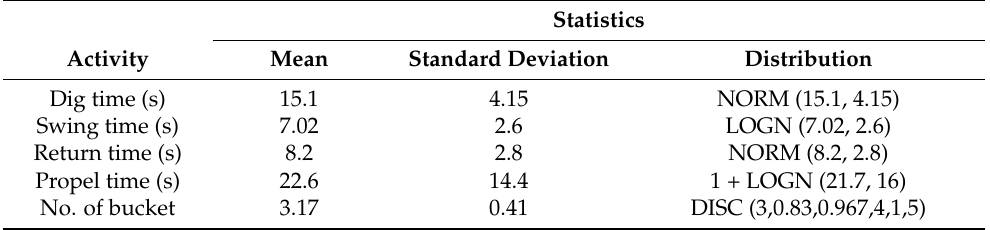
Table 2. Manual fleet key activity statistics.